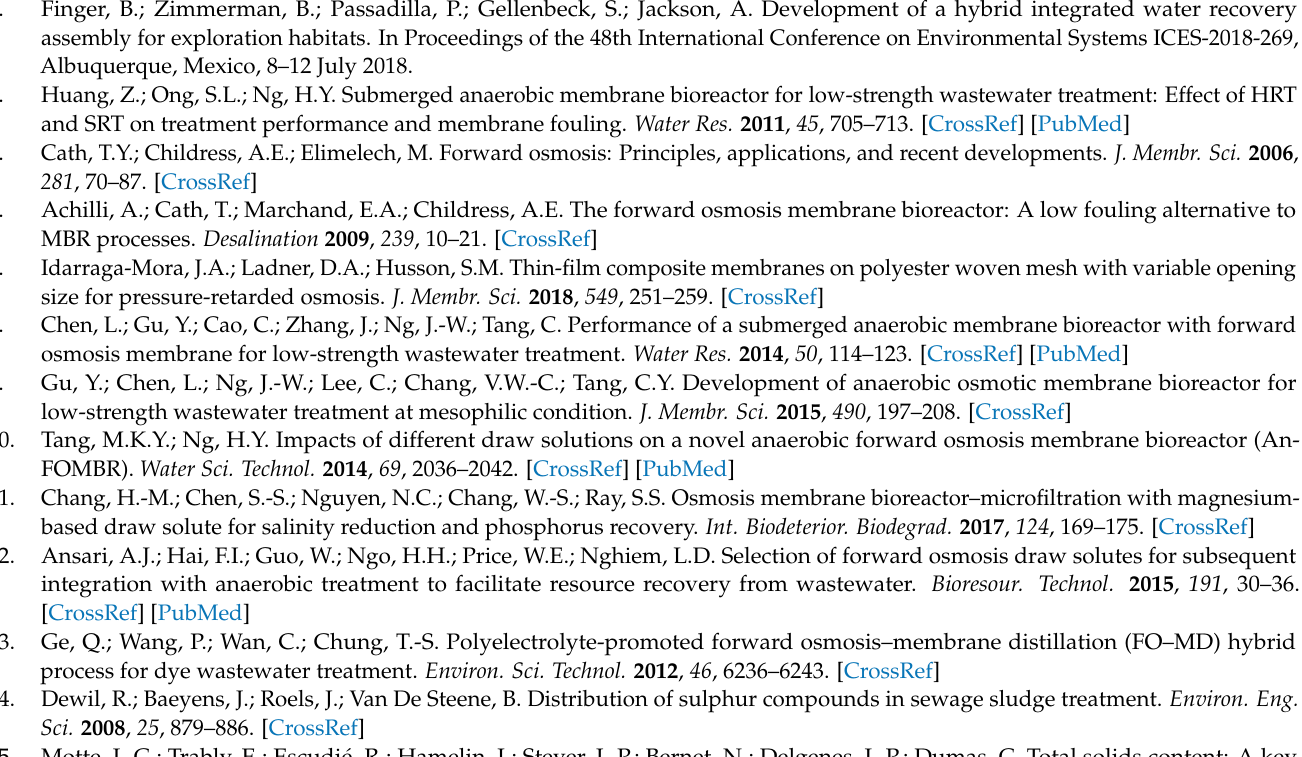
Figure S7: Crossflow pressure measurements, Figure S8: Long-term crossflow flux measurements, Figure S9: Linear and Flory–Huggins model fits to experimental osmotic pressure